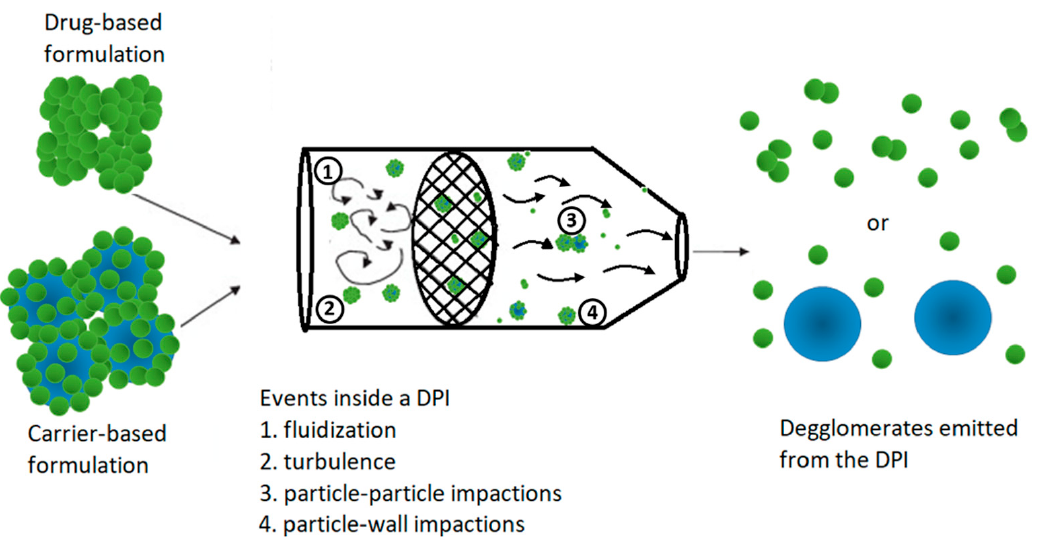
Figure 1. Schematics of dry powder inhaler (DPI) dispersion mechanisms.